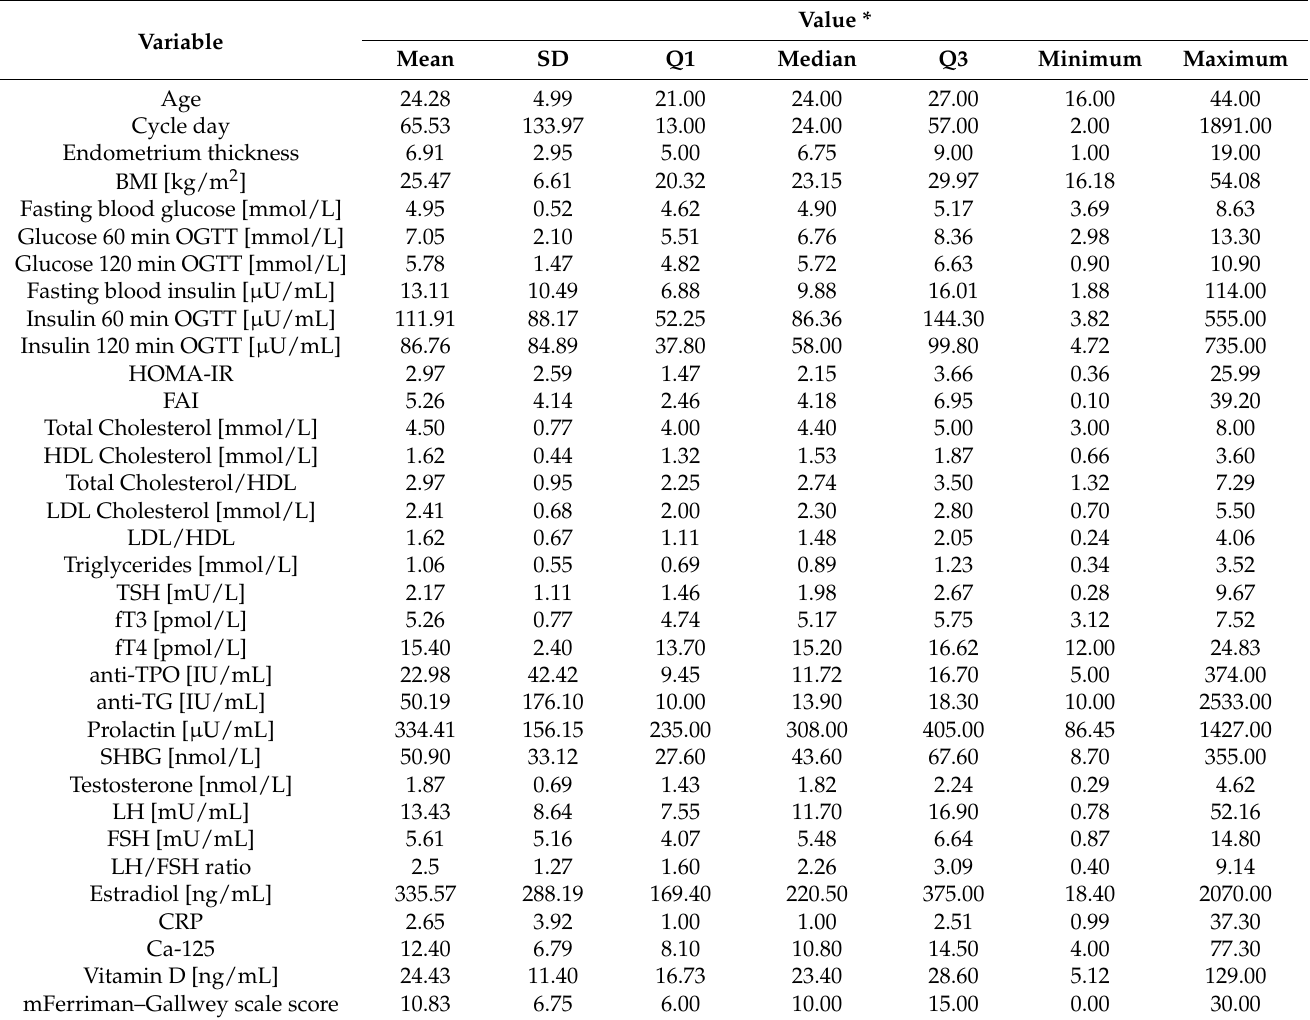
Table 1. Study population characteristics regarding selected clinical, hormonal and metabolic param- eters (N =